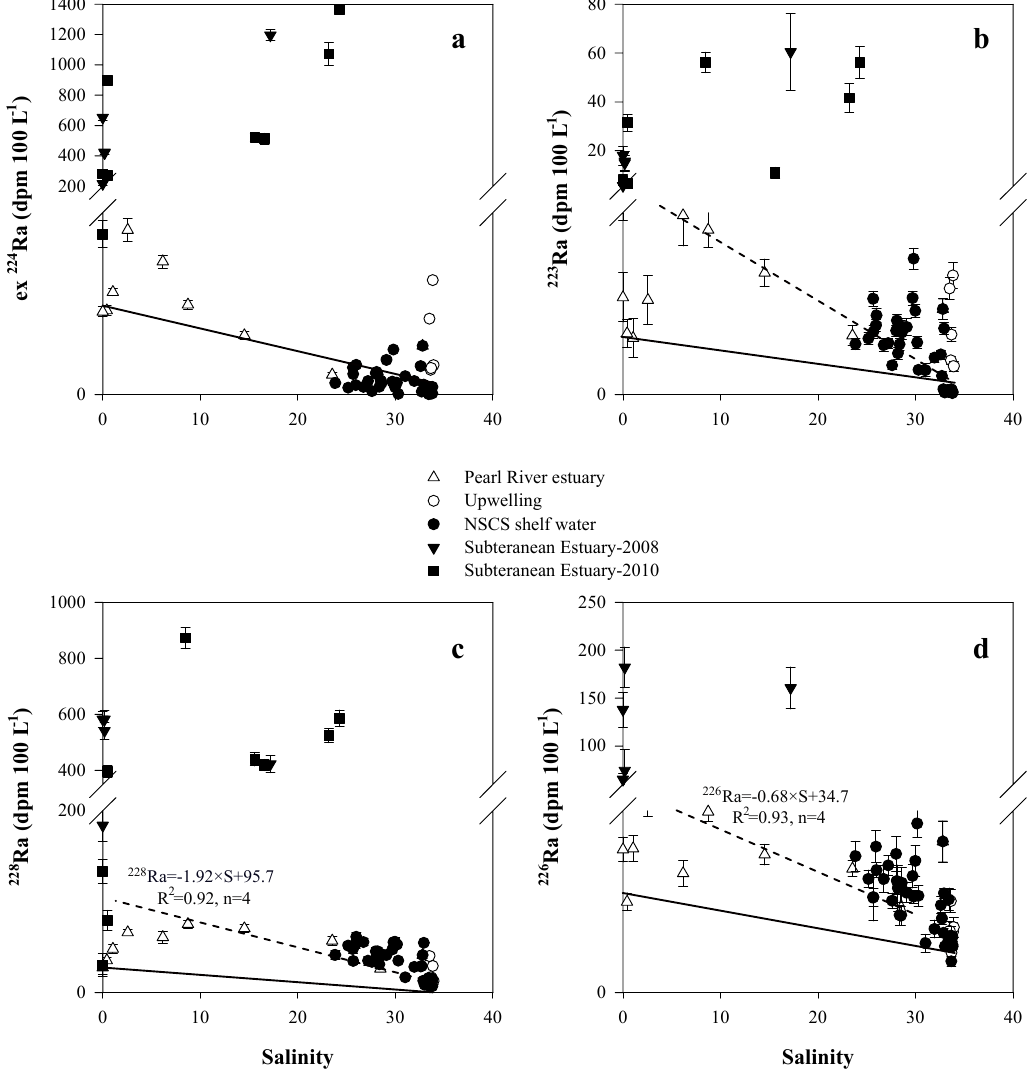
Fig. 6. Plots of (a) ex 224 Ra (excess 224 Ra, corrected for the ingrowth from 228 Th), (b) 223 Ra, (c) 228 Ra, and (d) 226 Ra versus salinity in the Pearl River estuary, northern South China Sea (NSCS) shelf waters and NSCS subterranean estuary. Solid lines represent the conservative mixing line between the freshwater end-member of the Pearl River and offshore surface seawater. Dotted lines denote conservative mixing after the Ra peak with salinity > 9 in the Pearl River estuary. The linear regression equations shown in panels c and d are based on the 228 Ra and 226 Ra vs salinity plots at salinity >